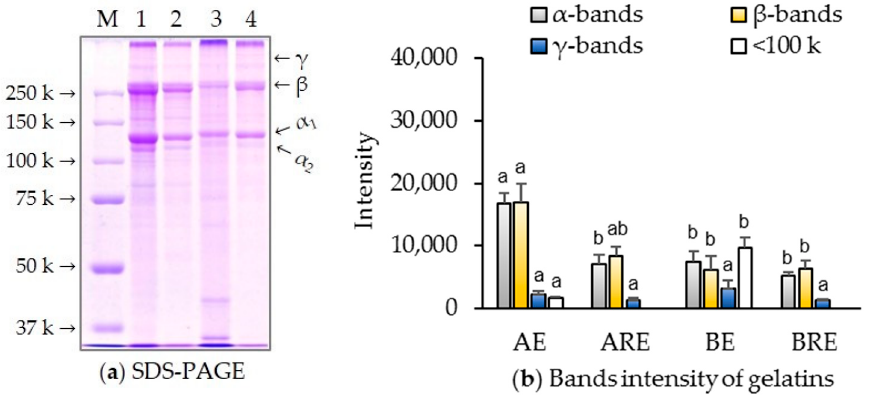
Figure 5. SDS-PAGE (7.5% gel) patterns ( a ) and the intensity of α -, β -, and γ - and low molecular-weight (<100 k) bands ( b ) of gelatins extracted from the head of Kalamtra sturgeon. M, molecular marker; 1, type A extracted gelatin (AE); 2, type A re-extracted gelatin (ARE); 3, type B extracted gelatin (BE); and 4, type B re-extracted gelatin (BRE). All gelatins were loaded as 10 µg/lane. Positions of α 1-, α 2-, β -, and γ -bands of gelatin were shown by arrows in ( a ). Columns and bars represent means and standard errors of three replicates, respectively, in ( b ). Different alphabets in each band show significant difference ( p < 0.05), in ( b ).